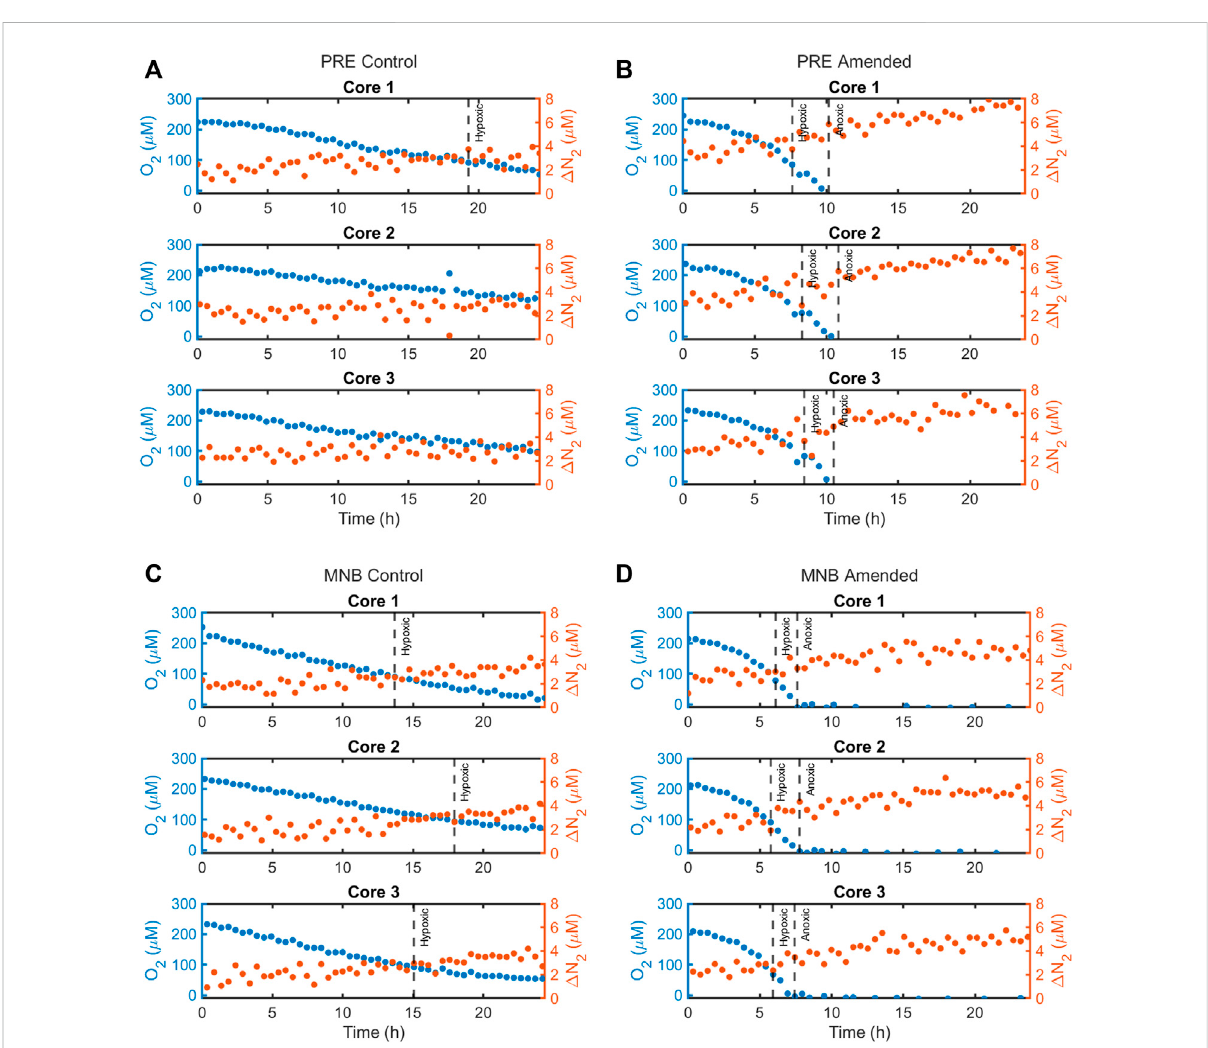
FIGURE 1 Calibrated concentration timeseries data for Δ N 2 (in red) compared to O 2 (blue), as measured by the fl ow-injection mass spectrometer system during the 24-h incubations for the four site and treatment combinations: (A) Providence River Estuary — Control treatment, (B) Providence River Estuary — Amended treatment, (C) Mid-Narragansett Bay — Control treatment, and (D) Mid-Narragansett Bay — Amended treatment. Δ N 2 represents the difference in concentration from the reference and was calculated from the modi fi ed N 2 /Ar technique (described in the main